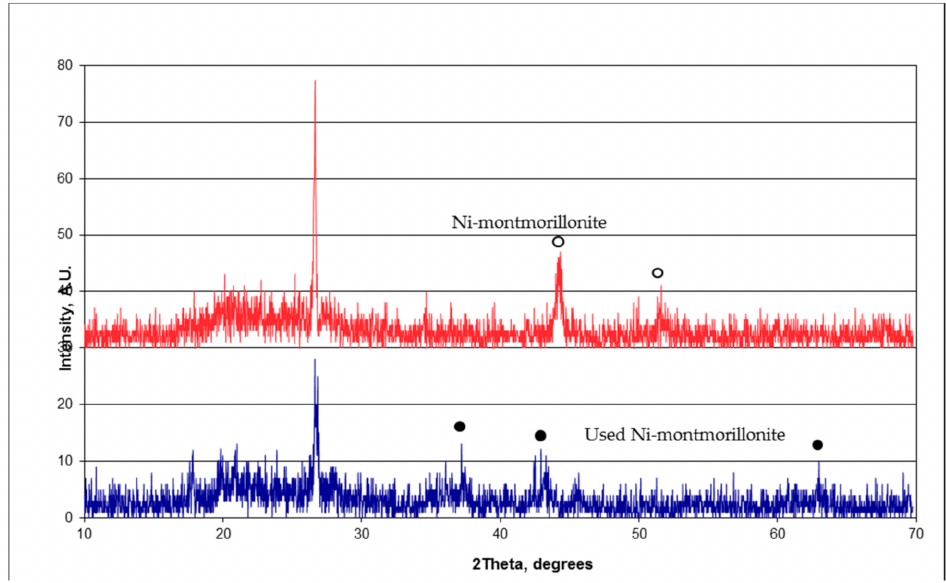
Figure 14. X-ray diffraction patterns of fresh and used Ni-montmorillonite. Transmission electron microscopy was performed on fresh and used catalyst to de- termine the size of nickel particles. Figures 15 and 16 provide the TEM images at 40,000 × magnification of fresh and post-run catalyst samples, respectively. The dark spherical spots on the catalyst surface represent the Ni particles. A broad particle size distribution is present in both cases. However, the metal particles on the used catalyst samples were larger compared to the fresh catalyst. Nickel particles on the fresh samples were up to 15 nm in size, which were smaller compared to the used catalyst. The size and shape of nickel particles reported by Ahmed et al. [51] were similar to the results from this study. The sizes of nickel particles were up to 50 nm on the used catalyst. This increase in the nickel particle size was due to sintering of nickel which occurs at high temperatures. Hence, one of the reasons for the decrease over time in the catalytic activity of Ni-montmorillonite can be attributed to the sintering of nickel particles. Sintering of nickel reduces the effec- tive surface area of nickel which in turn reduces the number of active sites, reducing the catalytic activity.